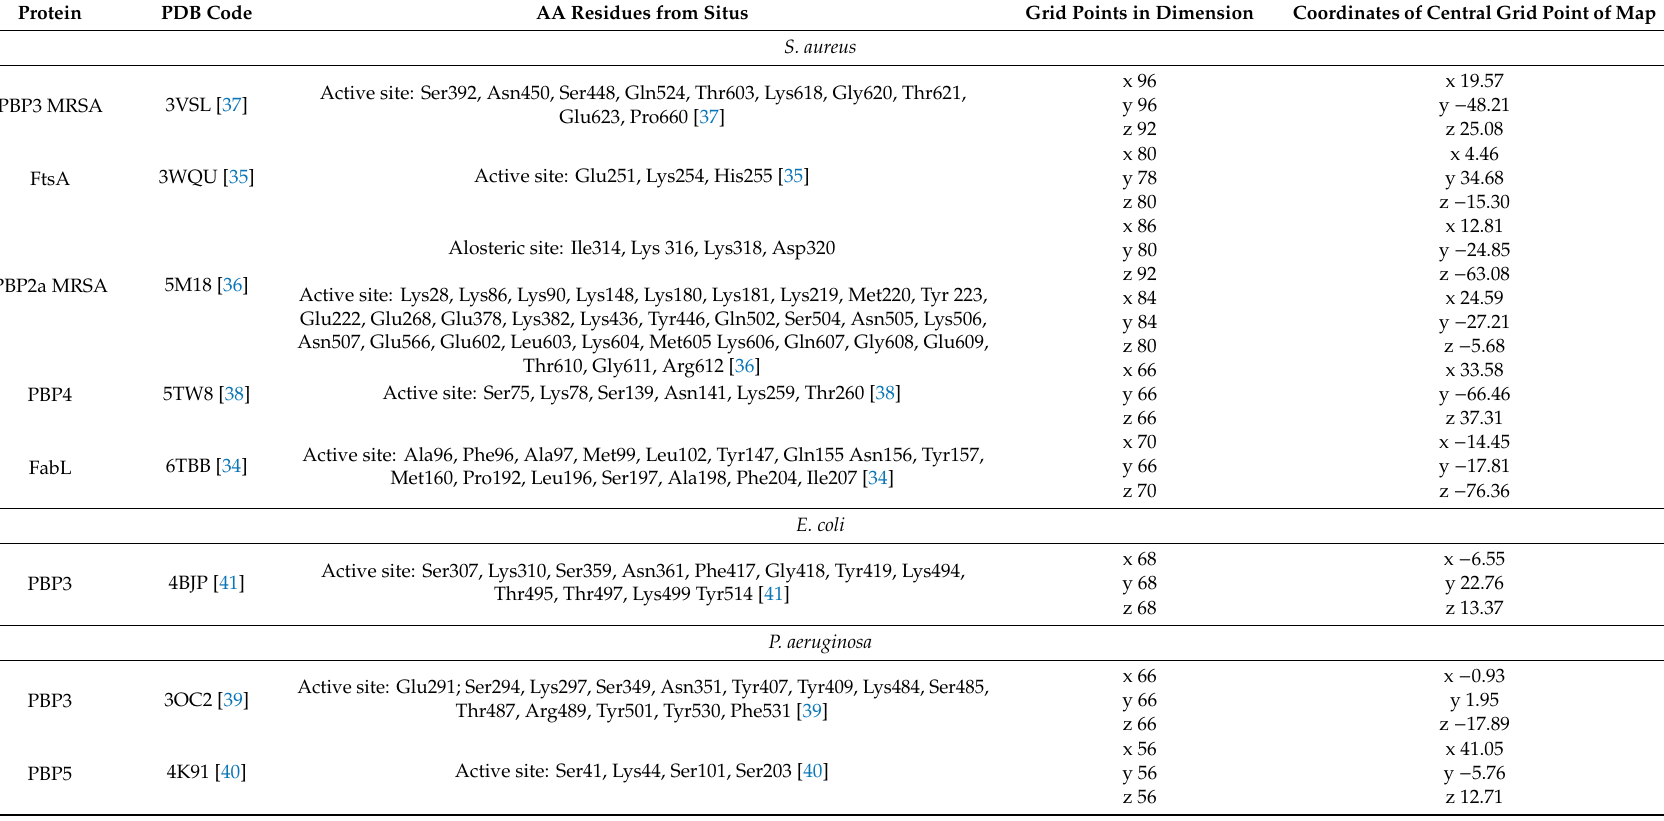
Table 1. Proteins selected for molecular docking approach. PDB code of the protein, AA residues from the situs of interaction. In this table, we also present the grid box parameters introduced in Autodock 4.2.6 software to generate the grid box for each molecular docking model: grid points in dimension (x, y, z) and the coordinates of central grid point of the